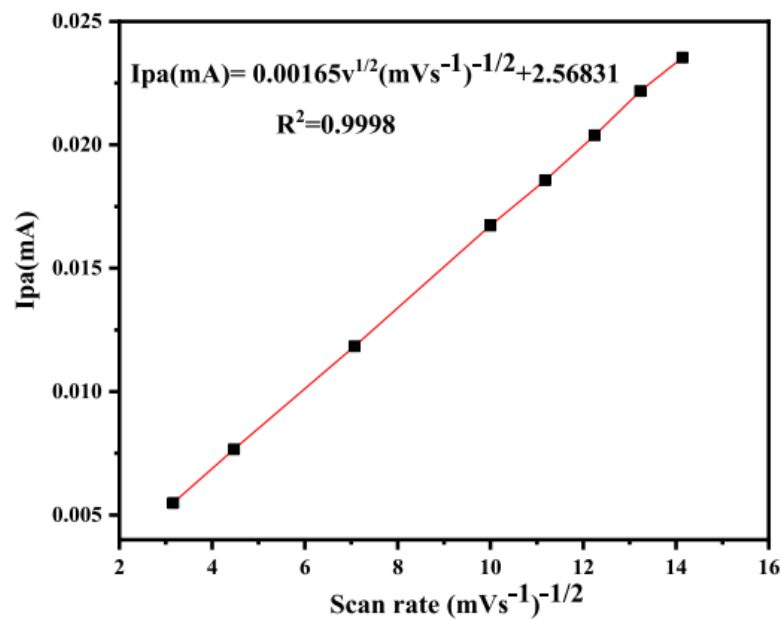
Figure 44. Dependence of anodic peak current on the square root of scan rate [82].